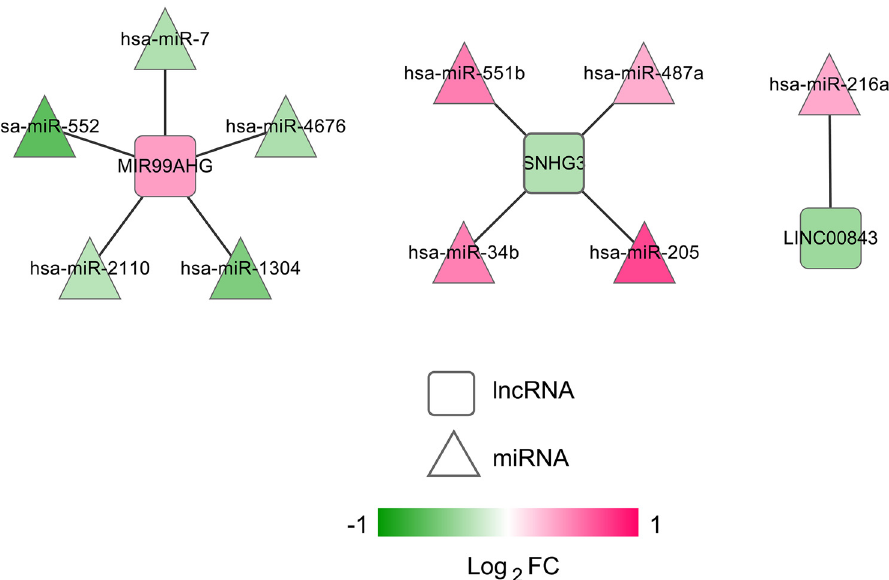
Figure 6: Signature lncRNA – miRNA network. Diamonds and triangles stand for lncRNAs and miRNAs, respectively.